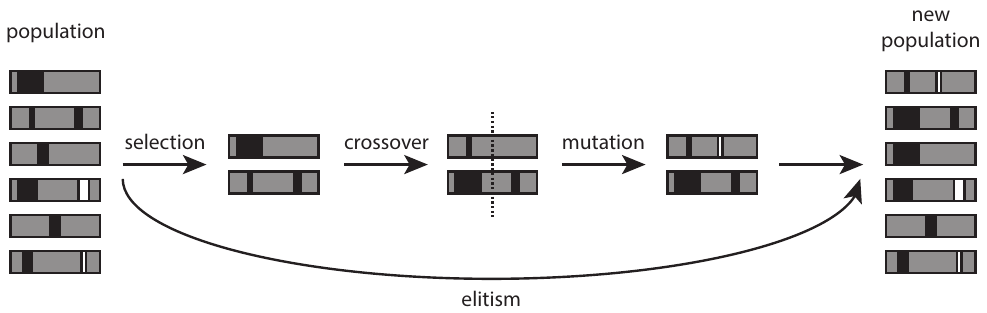
Figure 1. Schematic representation of the bioinspired processes (selection, crossover, mutation, and elitism) that occur during one step of a genetic optimization.